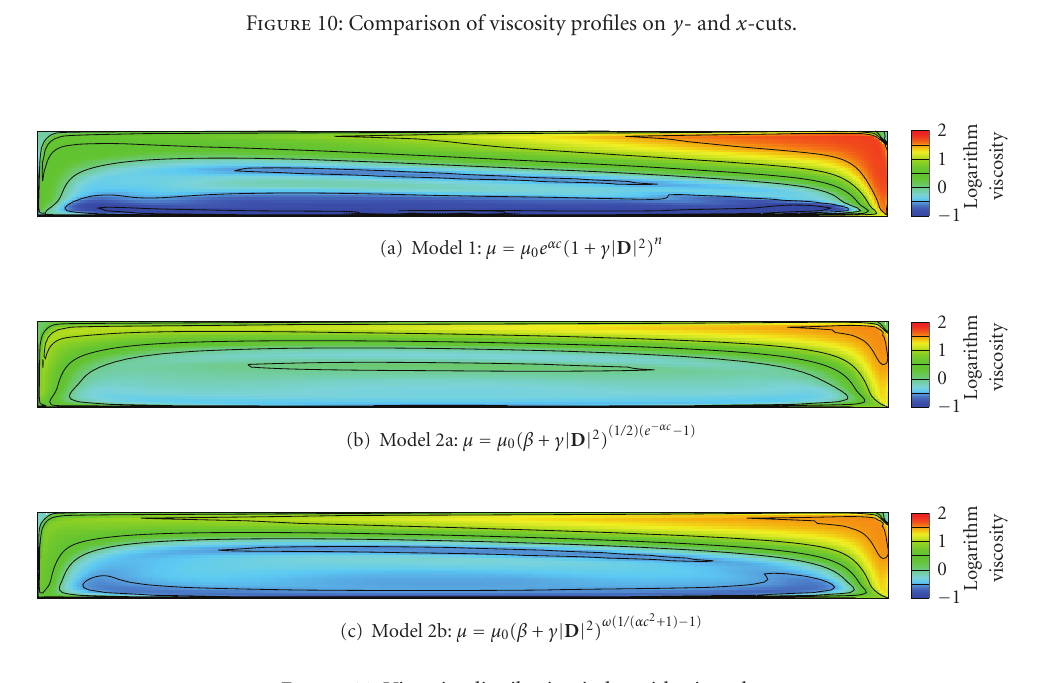
Figure 11: Viscosity distribution in logarithmic